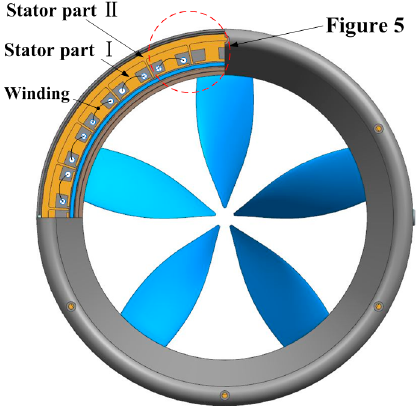
Figure 3. Stator armature of traditional RDT motor.